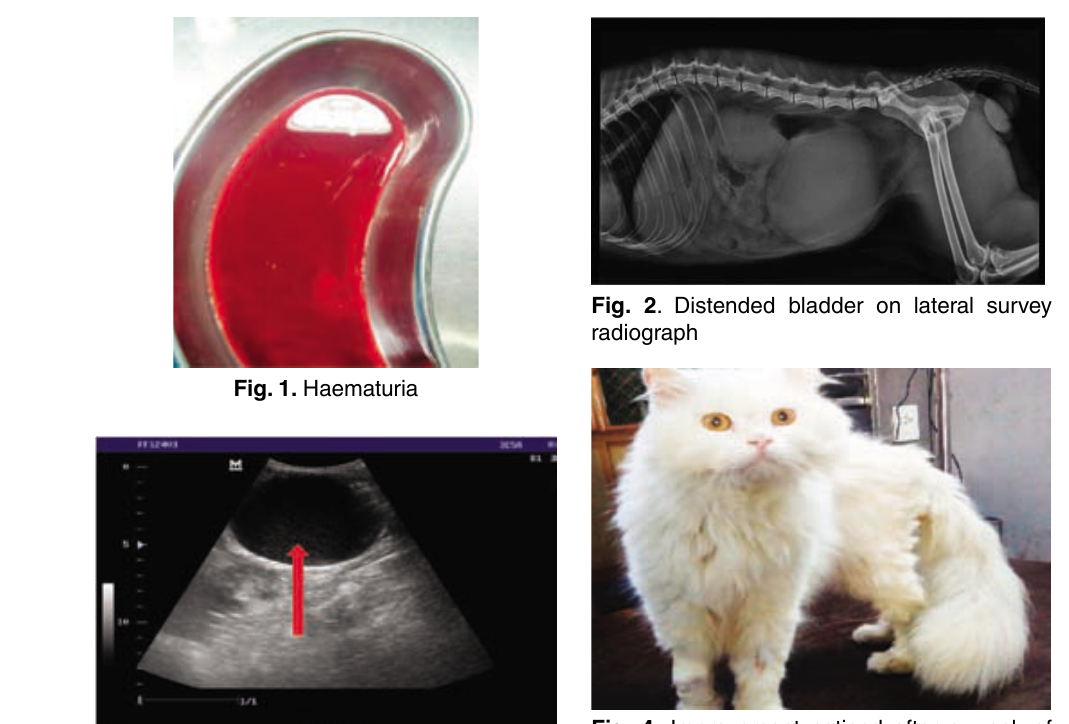
Fig. 4. Improvement noticed after a week of treatment Fig. 3. Distended bladder with